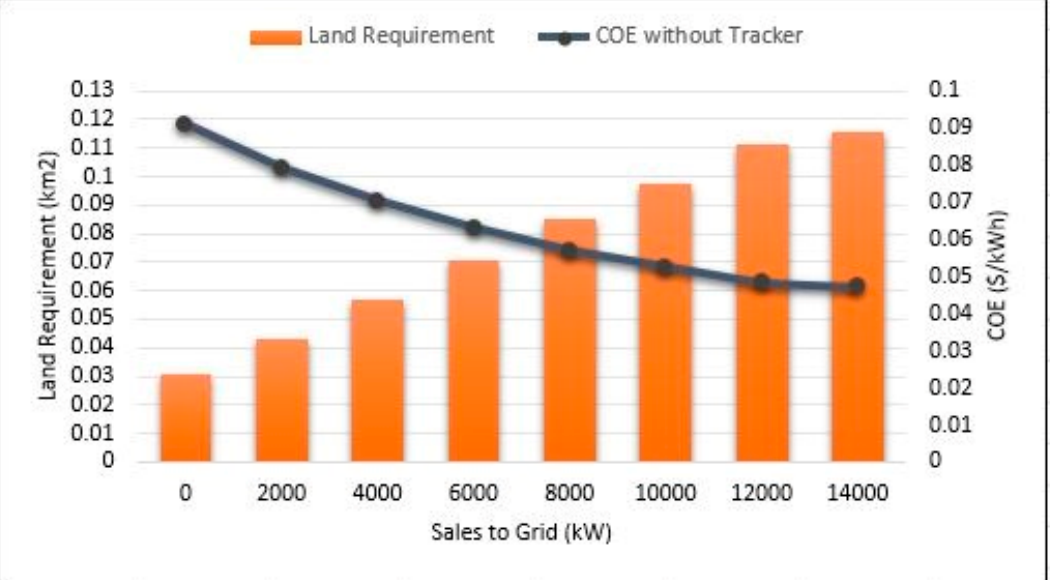
Figure 10. Land requirement and levelized cost of energy (LCOE) change of the system with different sales capacity .